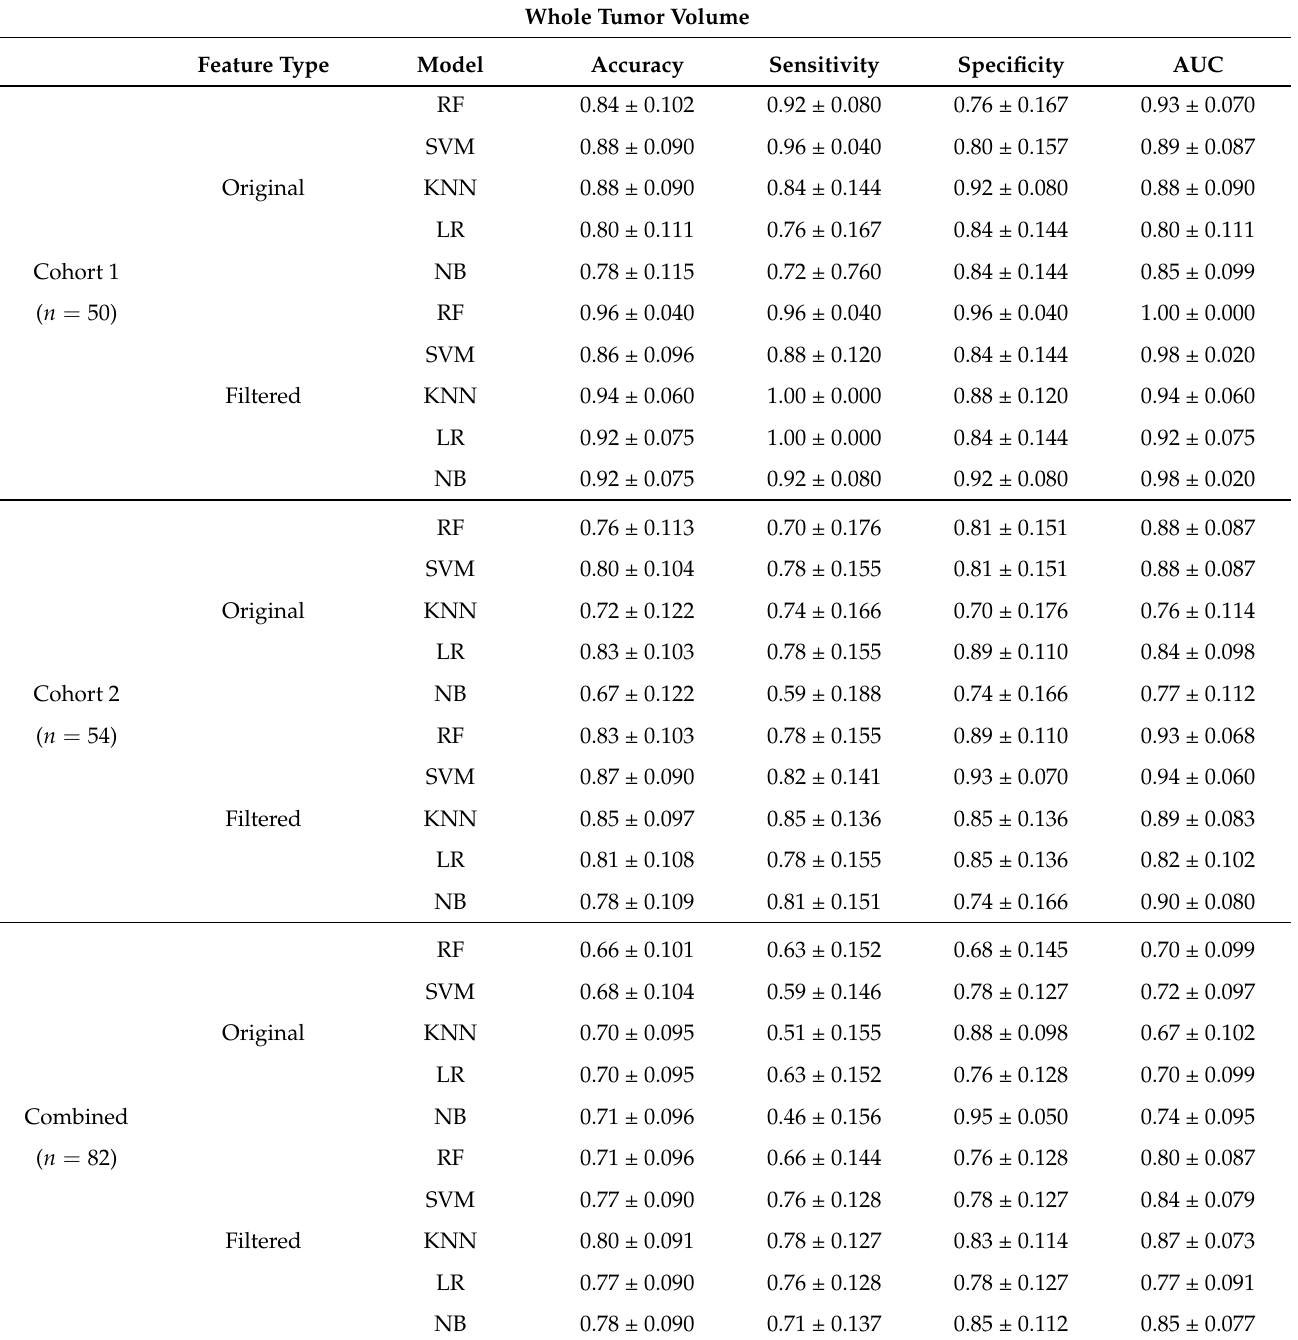
Table 10. Representation of diagnostic performance using whole tumor volume for different